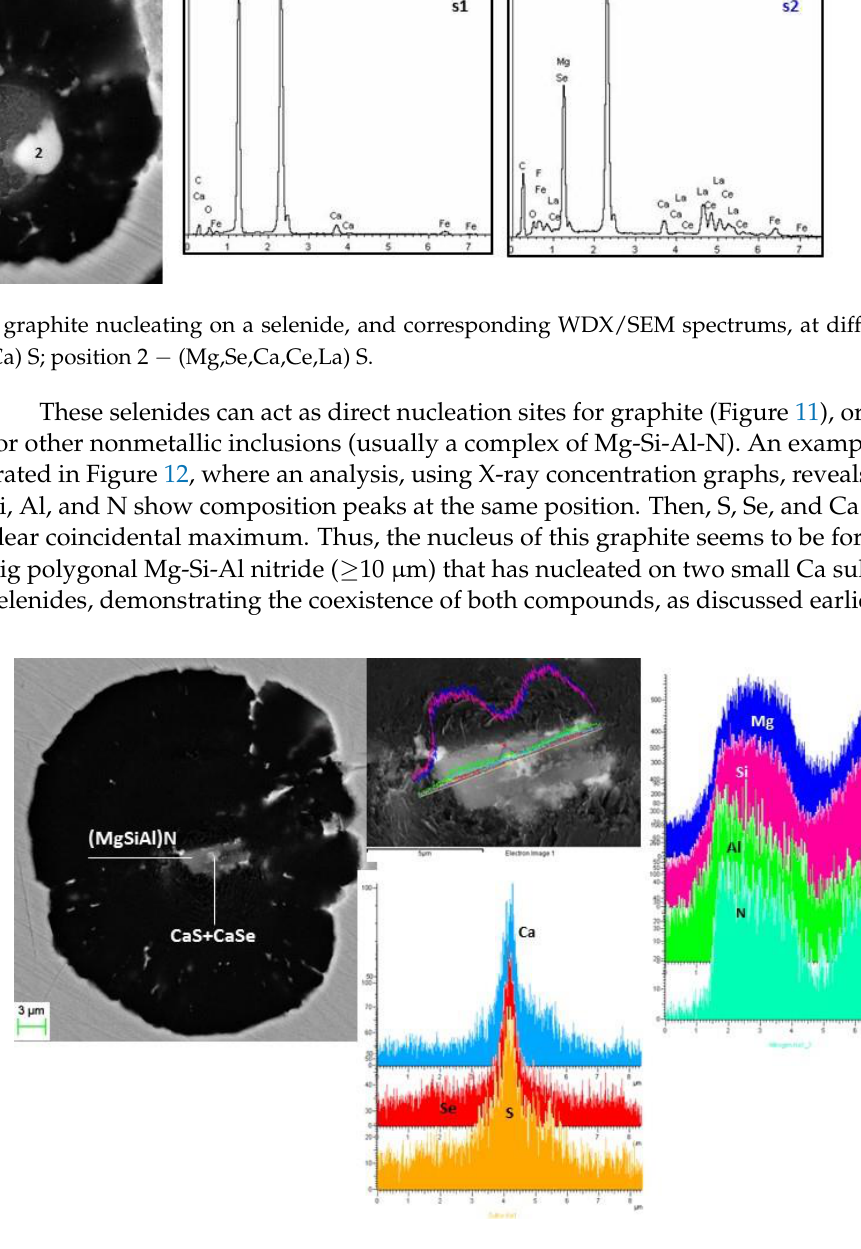
Figure 12. Determination of nuclei in function of X-ray concentration line scan graphs.